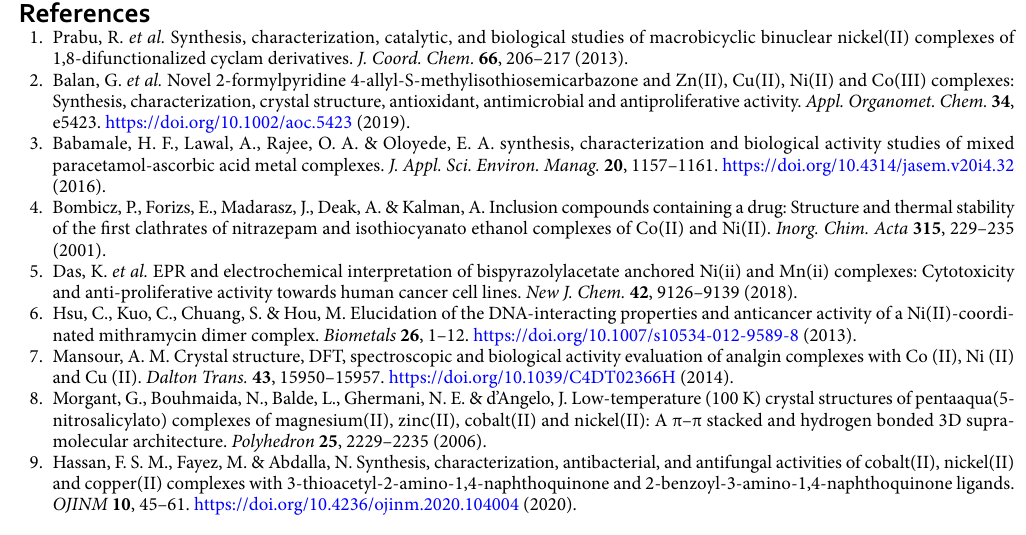
animals were followed. The animals were housed in disposable cages and allocated 2 rabbits per cage, next were scarified in accordance with the guidelines and regulations of Nicolaus Copernicus University and by qualified personnel with all certificates for killing animals in the laboratory (no. 14/2016 from 10/20/2016), required by the UE and Polish law.